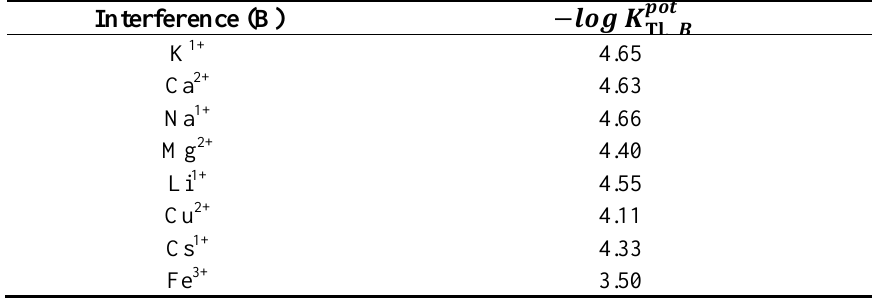
Table 1. The logarithm of the selectivity coefficient of the thallium ion sensor for different interferents in 1 × 10 −4 M